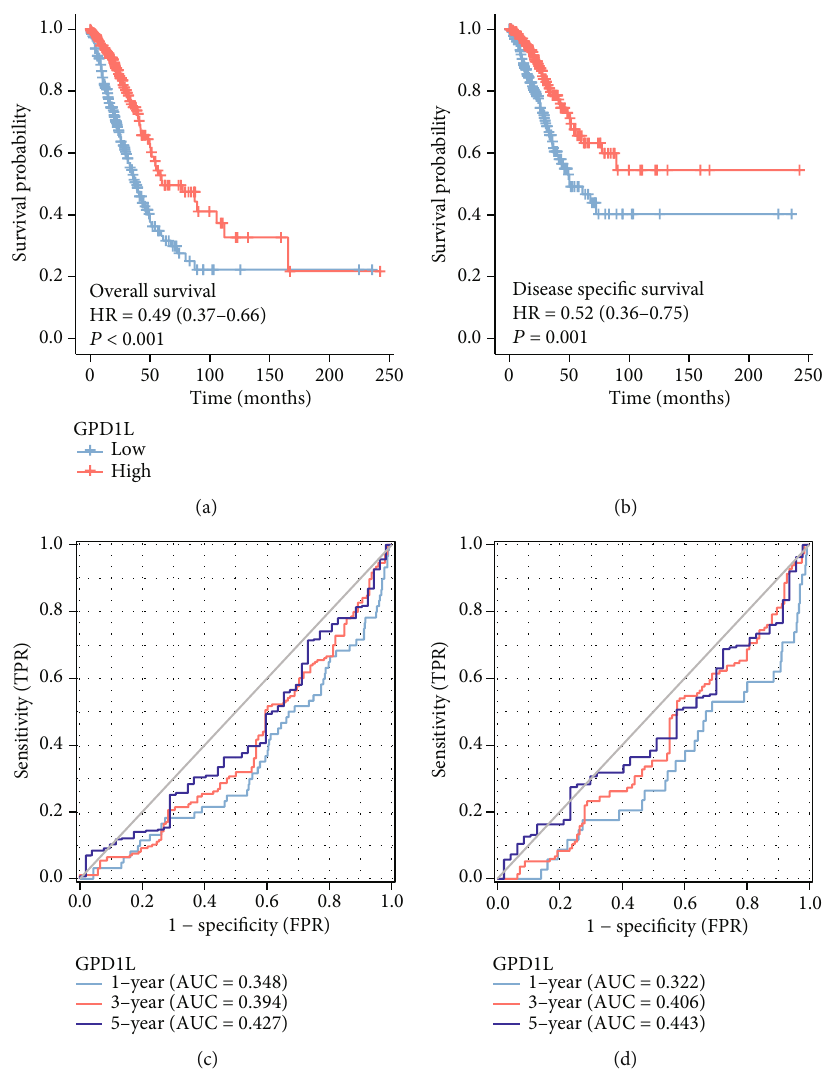
Figure 4: Analysis of the prognosis of GPD1L in patients with LUAD who were part of the TCGA cohort. Expression of GPD1L has been shown to have a correlation with both (a) overall survival and (b) survival speci fi c to the disease. (c, d) The predictive performance of GPD1L expression in TCGA is evaluated using time-dependent receiver operating characteristic